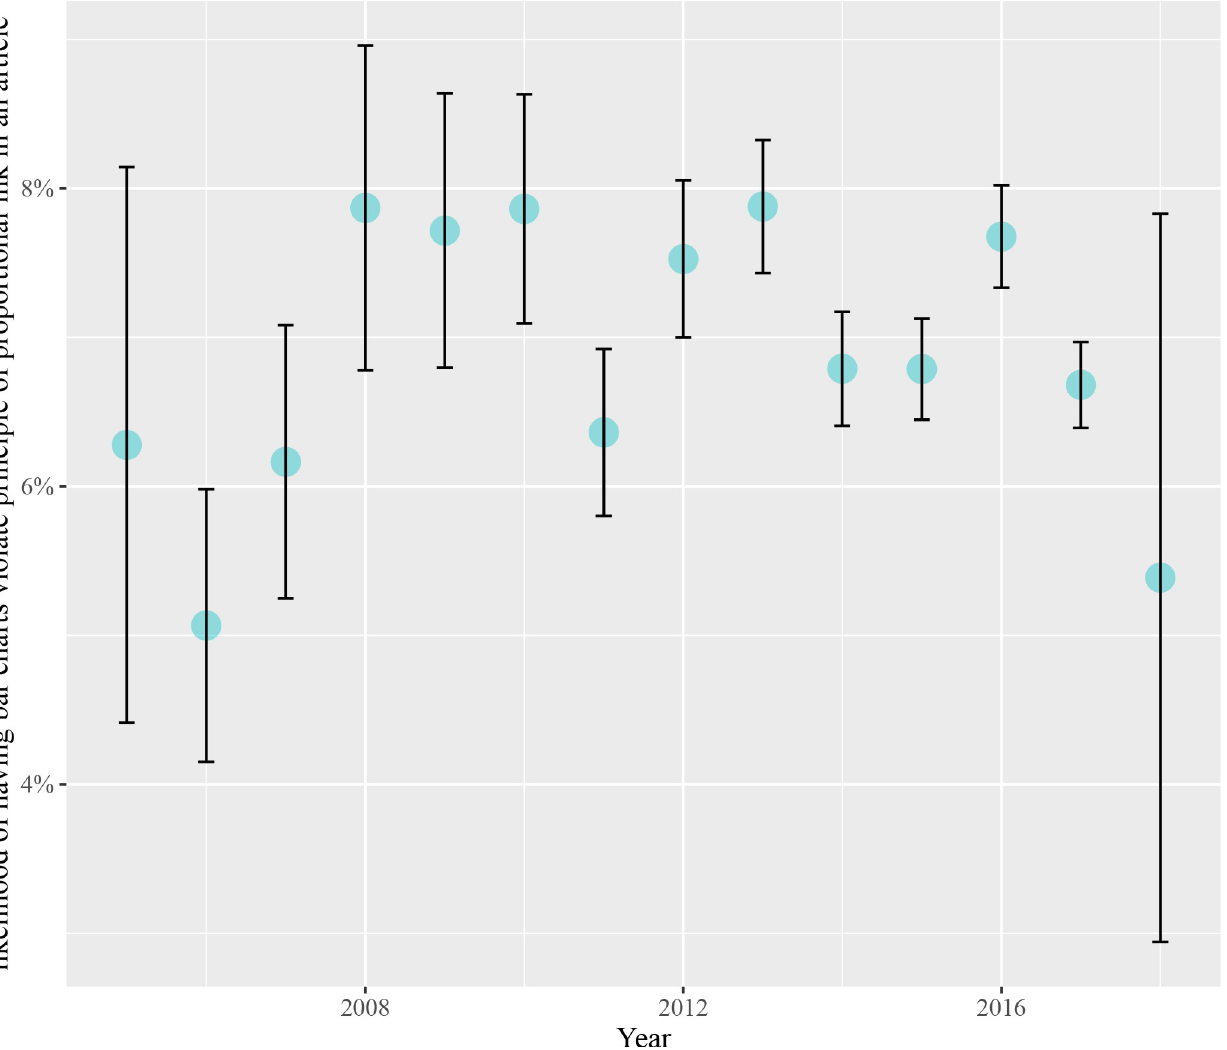
Fig 6. The likelihood of having graphical integrity issues across each